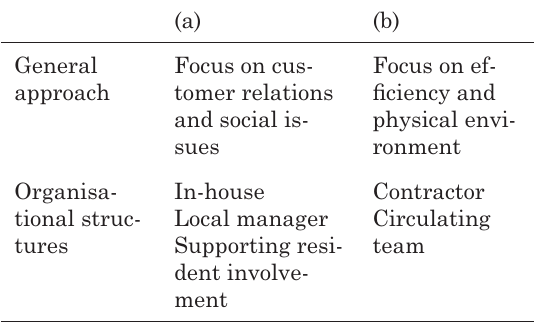
Table 5. The two general management approaches and their theoretical association to organisational